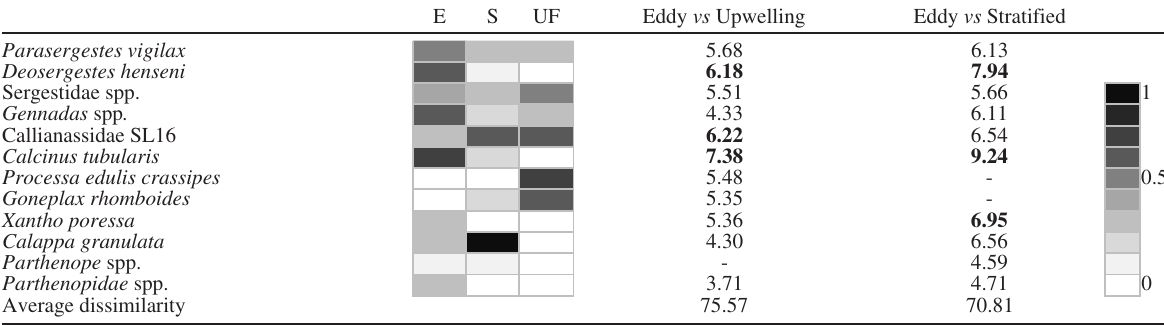
Table 2. – Pairwise comparisons of decapod larva assemblages between the regions: E, eddy; S, stratified; UF, upwelling filaments (see the “statistical analysis” section for details). Values correspond to the percentage of dissimilarity (SIMPER analysis) of the species that contrib- uted to 70% average dissimilarity. In bold, the three species that mostly contribute to the differences among regions. Grey scale corresponds to changes in mean relative abundance (log(larvae/100 m 3 +1)) in each